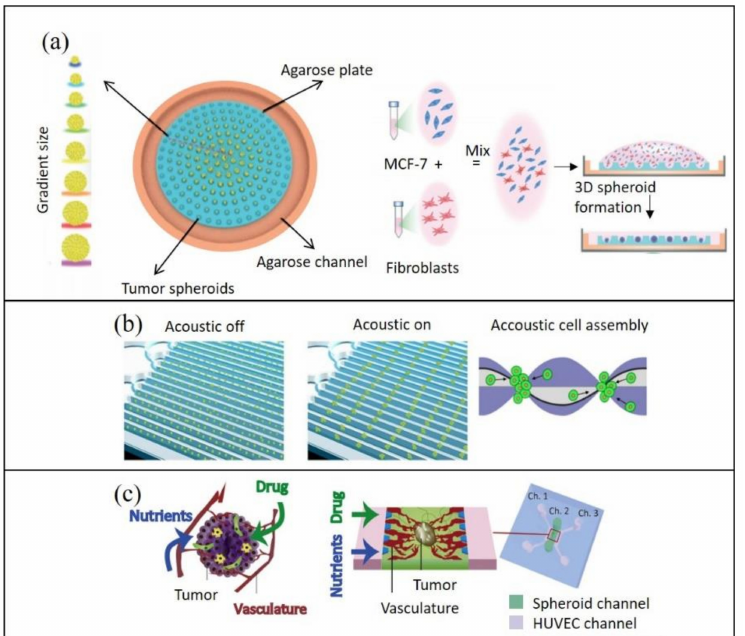
Figure 1. Representative schematics of technological advances in microfluidics for tumor-on-chip generation: ( a ) an agarose microfluidic chip capable of position-dependent distribution of tumor spheroids, with gradient-controlled sizes under a liquid dome (left) and co-culture of a breast cancer cell line (MCF-7) and human dermal fibroblasts (right) (adapted from [25]); ( b ) an acoustofluidic high-throughput tumor spheroid assembly platform with multiple channels and a reusable surface acoustic wave generator (left), also showing the tumor spheroid formation (right) (adapted from [11]); ( c ) vasculature of an in vivo tumor (left) and recapitulation of the vascular network for in vitro microfluidic tumor models (right) (adapted from